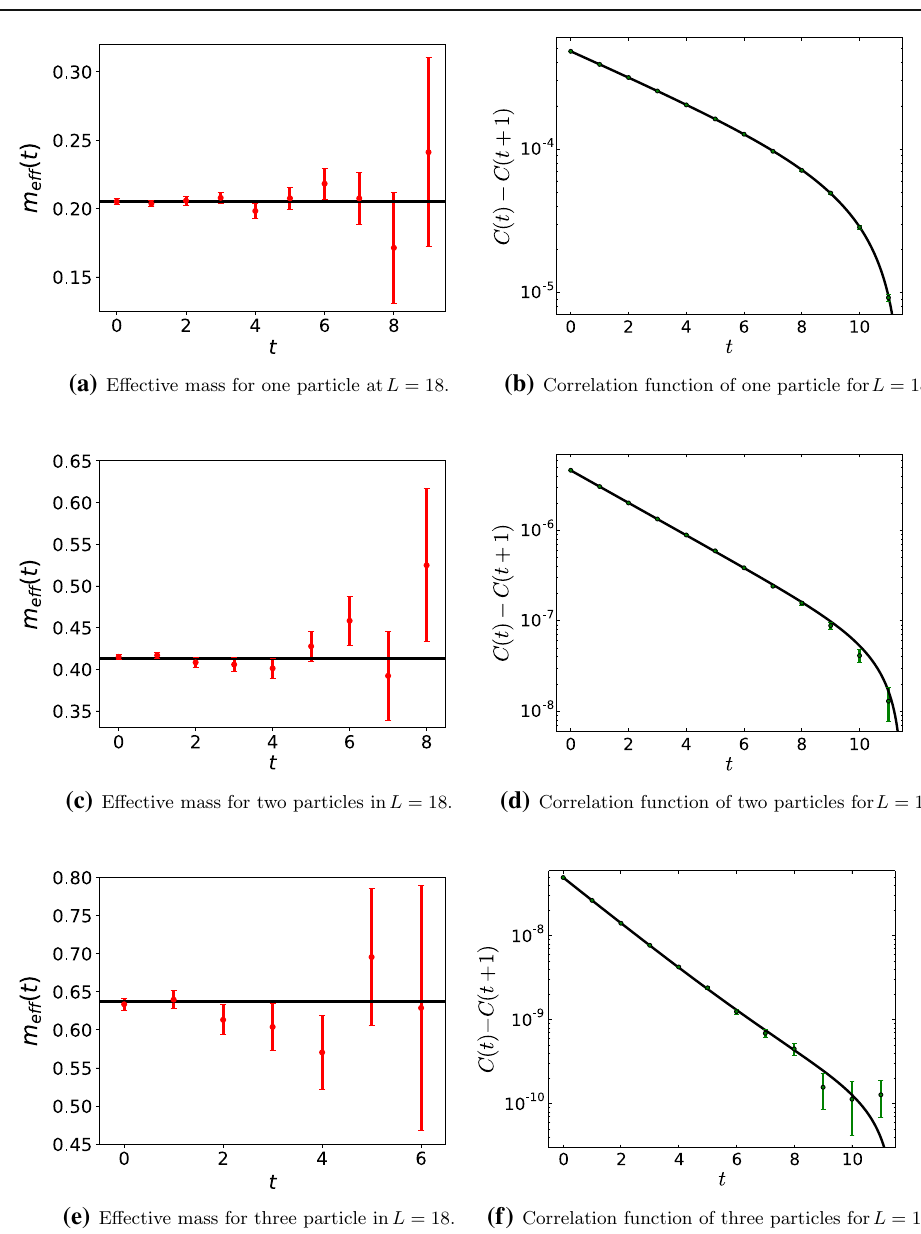
Fig. 11 Relevant plots for our analysis at L = 18